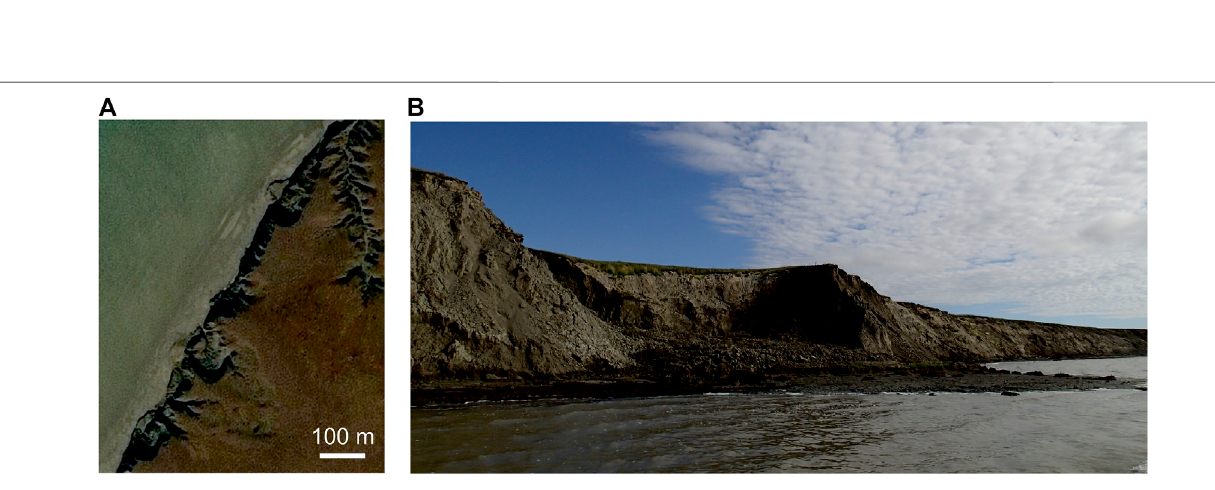
Frontiers in Earth Science |